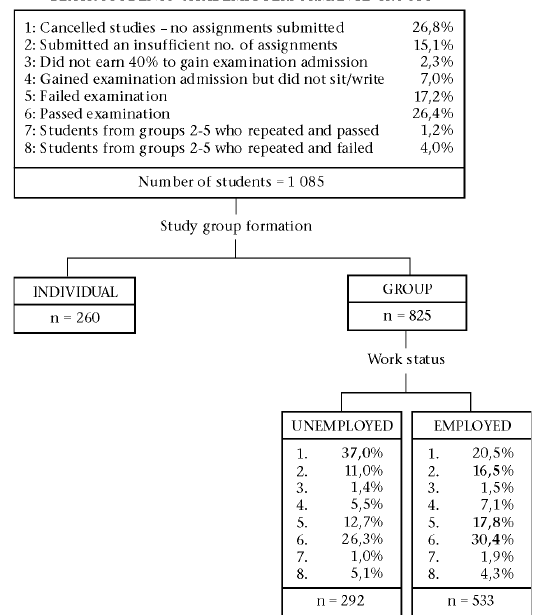
Figure 4: Dendogram of the coloured/Indian students